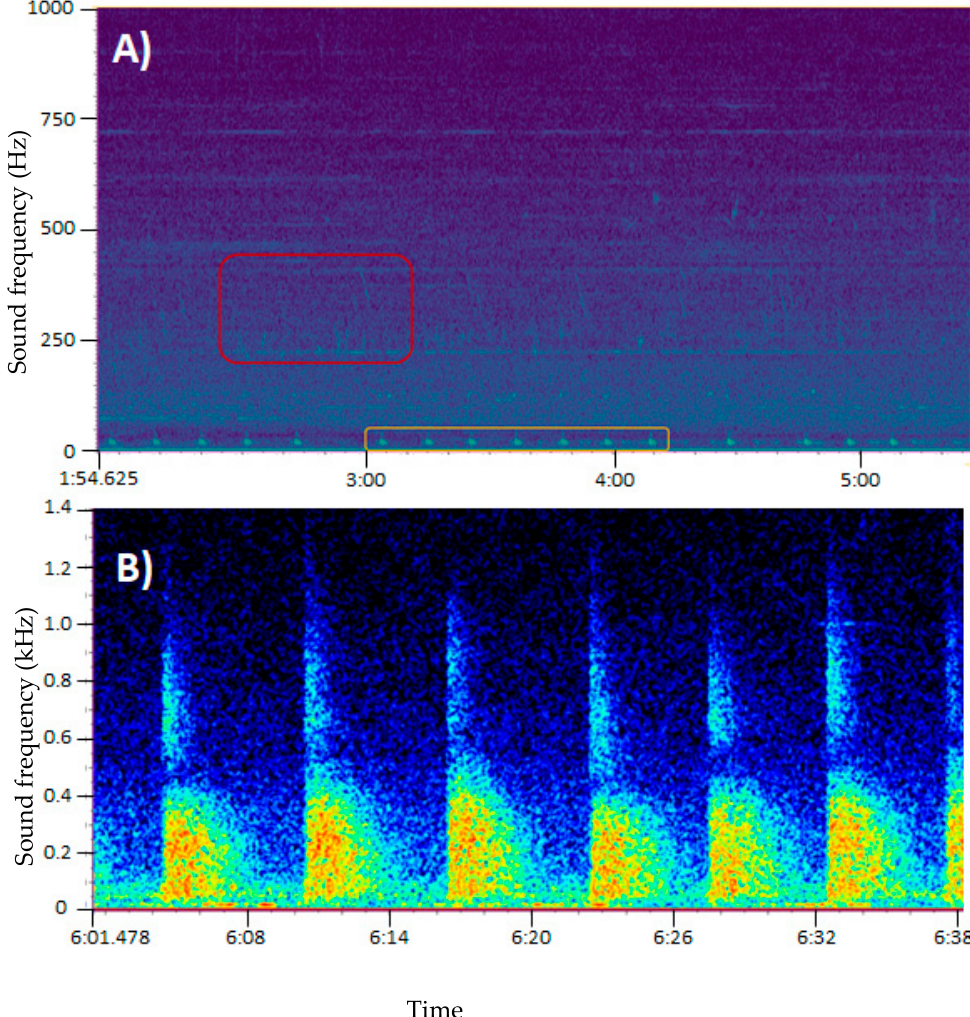
Figure 7. Spectrogram showing the narrow frequency of a humpback whale (red) and a fin whale (orange) vocalization ( A ) and airgun shots from a seismic survey ( B ). Color represents sound from low (dark blue) to high intensity (yellow–red). Data collected with the Seaglider ® equipped with an Observer/AMAR G4 from JASCO.